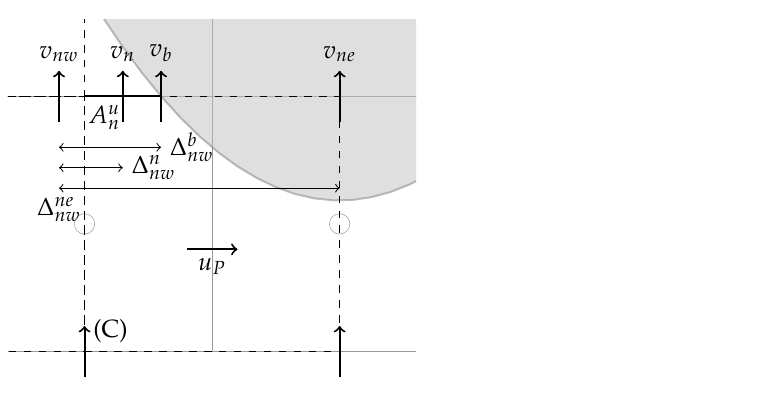
Figure 4. Case (C) cut u -cell interpolation for v n at cut face A u n , v nw on fluid, v ne on solid and v b on interface.